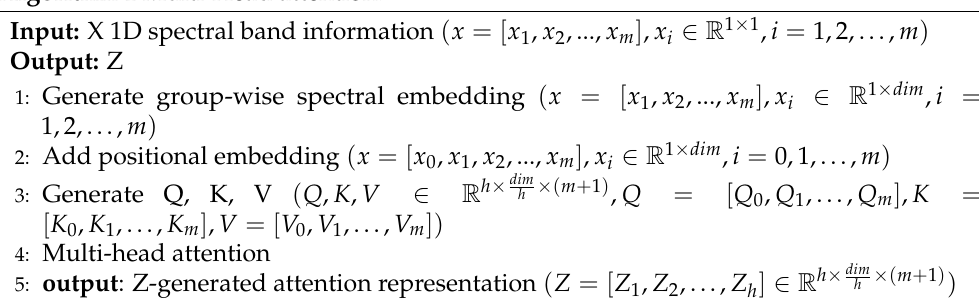
Algorithm 1 Multi-Head